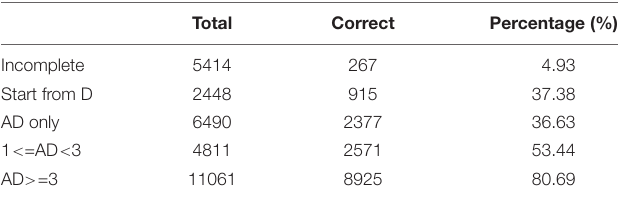
TABLE 4 | All contracted levels of AD sequence with sample size and percentage of